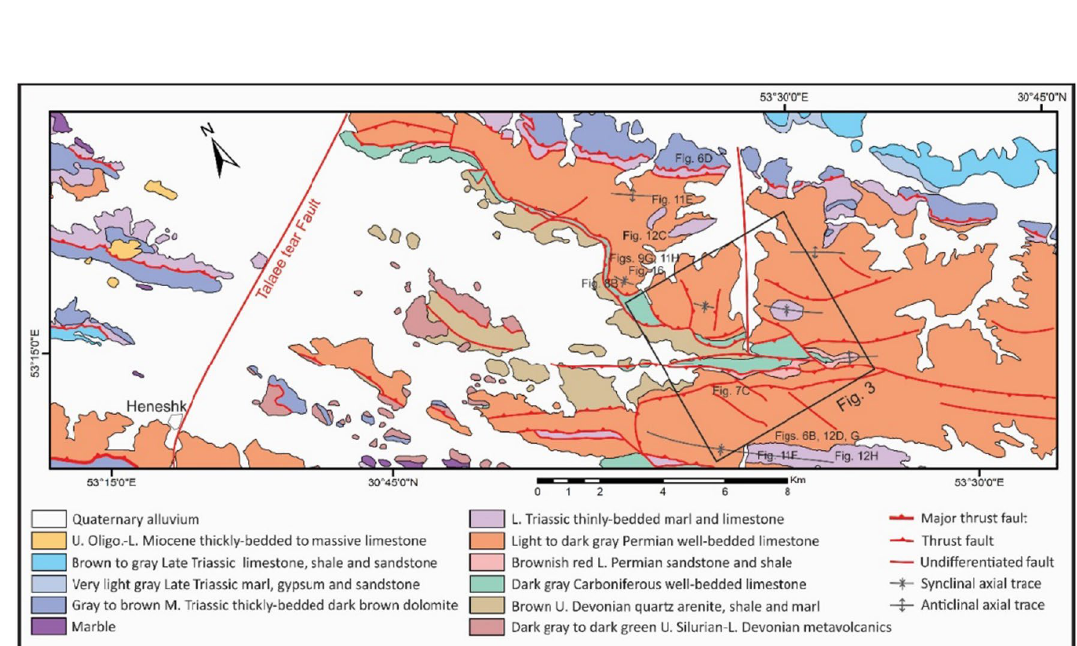
Figure 2. The geological map of the study area prepared after field working by authors using CorelDraw 2018 and ArcGIS